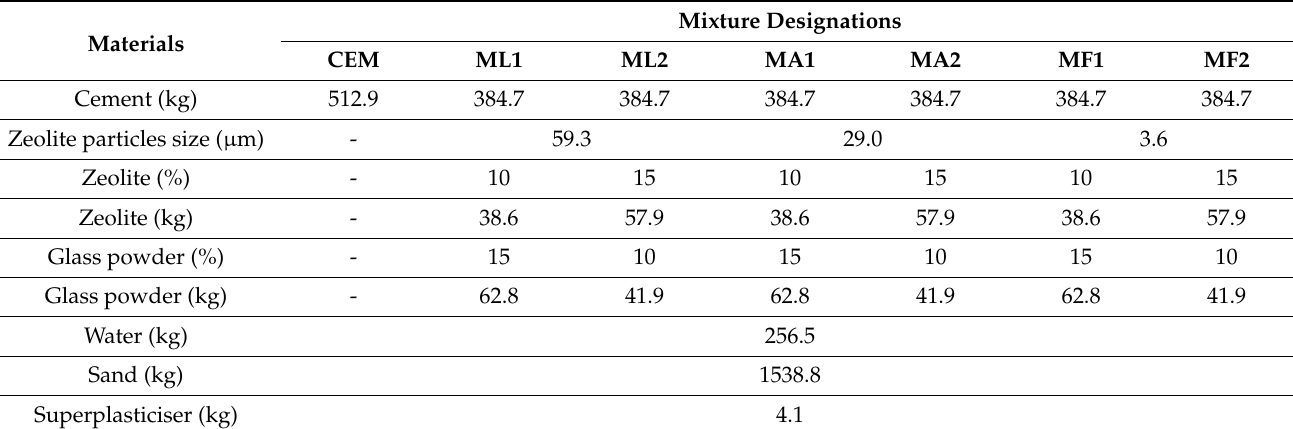
Table 4. Compositions of cement mortars No 2 (for the mixture volume of 1 m 3